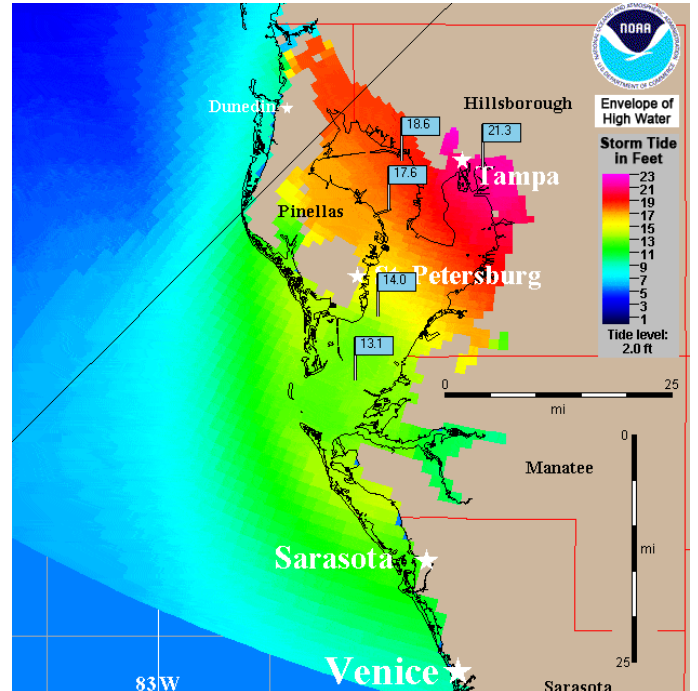
Figure 2. Predicted storm tide (storm surge superimposed on high tide) height for a category 4 hurricane making land fall on Tampa Bay at high tide. Due to the funneling effects of the bay, the areas in the upper (northeastern) part of the bay where Tampa’s city center is located could expect over 20 feet of flooding. Model results from NOAA’s National Hurricane Center utilizing the sea, lake, and overland surges from hurricanes (SLOSH) model. Source: Public domain NOAA image also presented in [87].